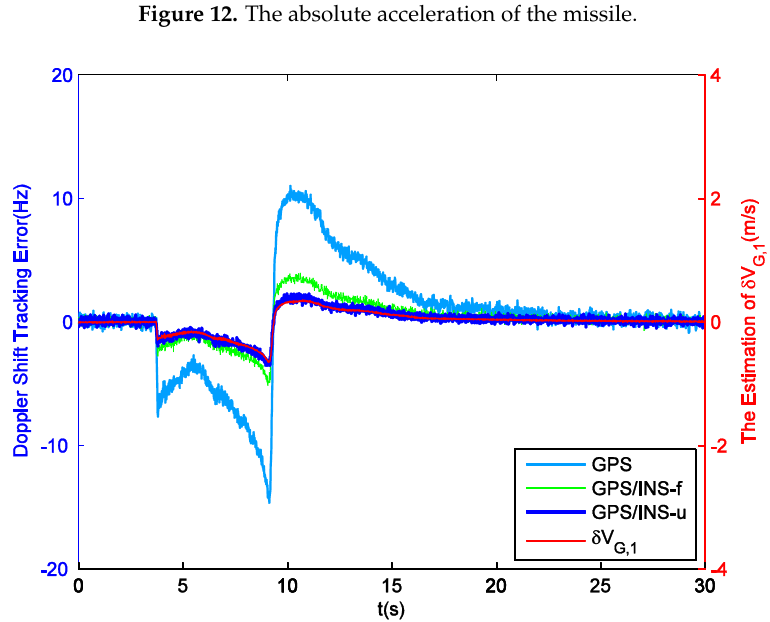
Figure 13. Doppler shift tracking error for PRN5 and the estimation of 𝛿𝑣 𝐺,1 .